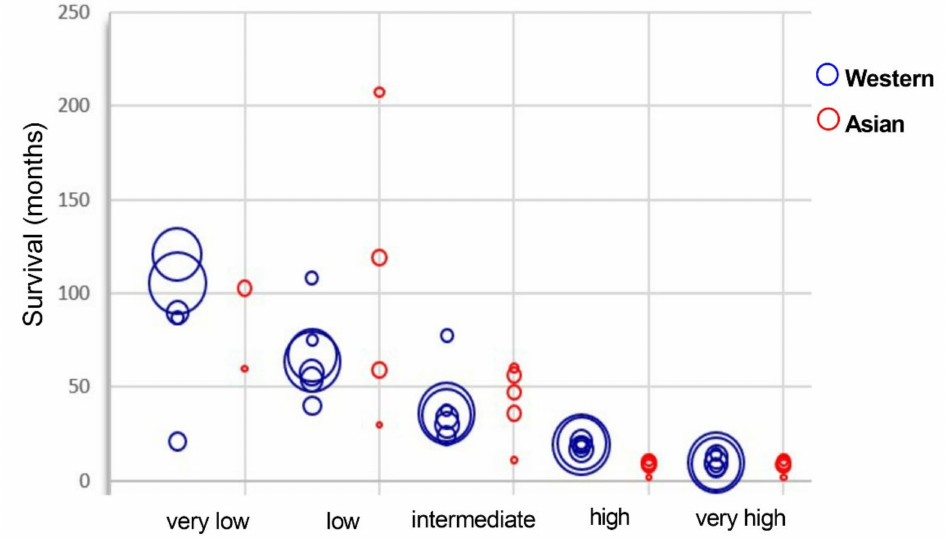
Figure 8. Survival depending on IPSS-R in Western and Asian countries. The size of the circles indicates the sample size of each study. The graph was drawn upon publications [26,29,31,36,40,42–48]. Raw data and statistical analyses are presented in Supplemental Table